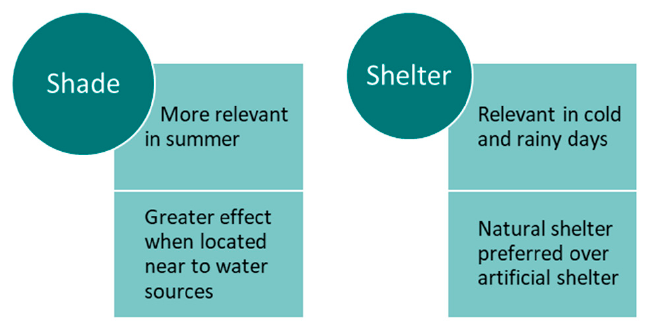
Figure 9. Main characteristics of the effect of shade and shelter on the distribution of cattle in the